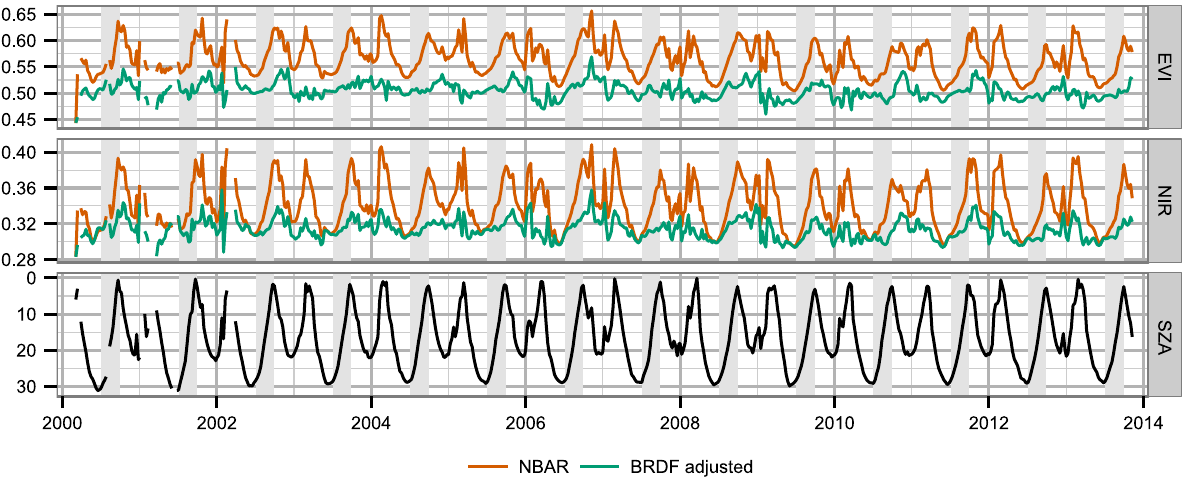
Figure 2: Spatially averaged viewing zenith angle (NBAR) and viewing and sun zenith angle adjusted (BRDF-adjusted, VZA = 0°, SZA = 30°) EVI and NIR for MODIS tiles h11v09 and h12v09, lines connect data points, solar zenith angles are reversed to facilitate comparison with vegetation index trends, 8 day temporal resolution, grey bands indicate typical dry seasons (July to